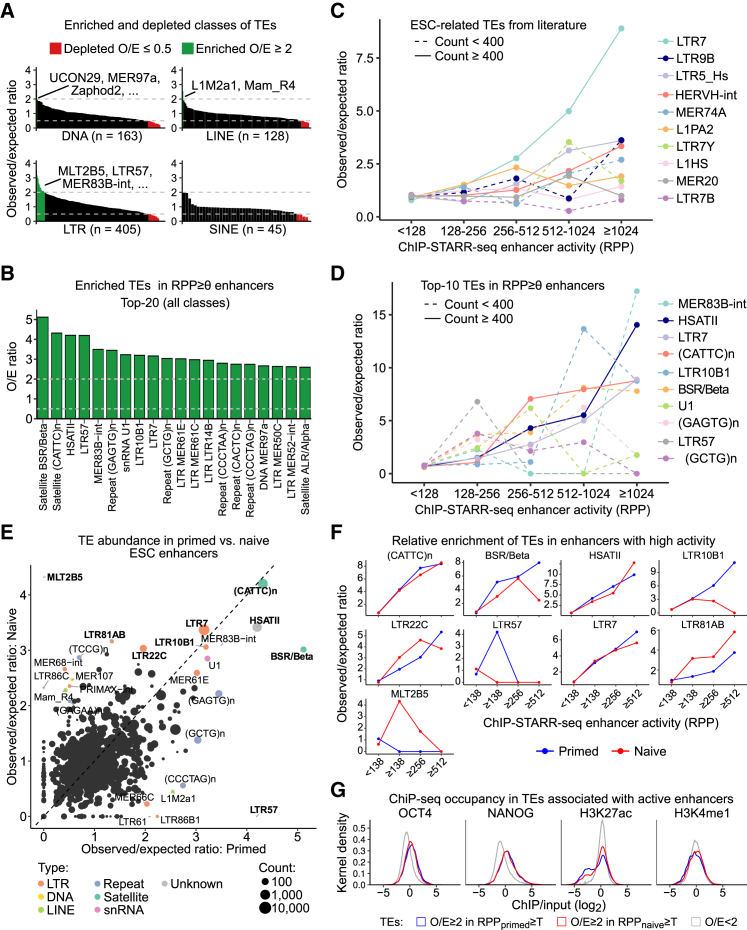
Distinct Transposable Elements Are Associated with Enhancers of Differing Activity in ESCs(A) Enrichment ratios for the occurrence of TE families (LTR, DNA, SINE, and LINE) in high activity ChIP-STARR-seq enhancers (RPP ≥ 138).(B) Top-25 most enriched TE families in active enhancers.(C) Enrichment ratio versus activity level for distinct TE families.(D) Like in (C), but for the top-10 most enriched families of TEs in (B).(E) Comparison of the enrichment ratios in primed and naive ESCs. Each repeat element is shown by a dot with the size proportional to the number of overlaps with ChIP-STARR-seq regions. Elements with O/E ≥ 3 in naive or primed or with strong differences between both (O/E ≥ 2 and Δlog2(O/E) ≥ 2) are labeled.(F) Relative enrichment of selected TEs (from E) in primed (blue) and naive (red) ESCs as a function of enhancer activity level (RPP).(G) Kernel density plots of coverage (ChIP-seq/input) in ESCs for the indicated factor for all TEs overrepresented (O/E > 2) in active enhancers.